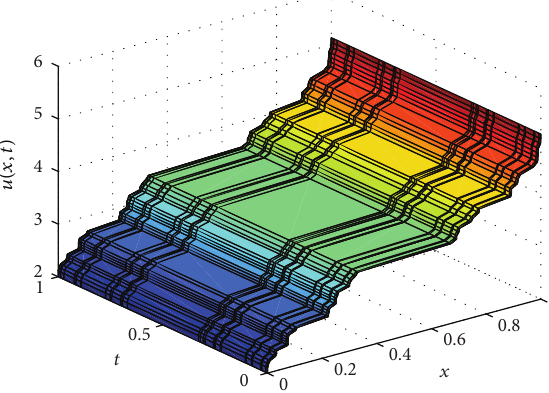
Figure 1: Graph of 𝑢(𝑥, 𝑡) with the parameter 𝛼 = ln 2/ ln 3 .